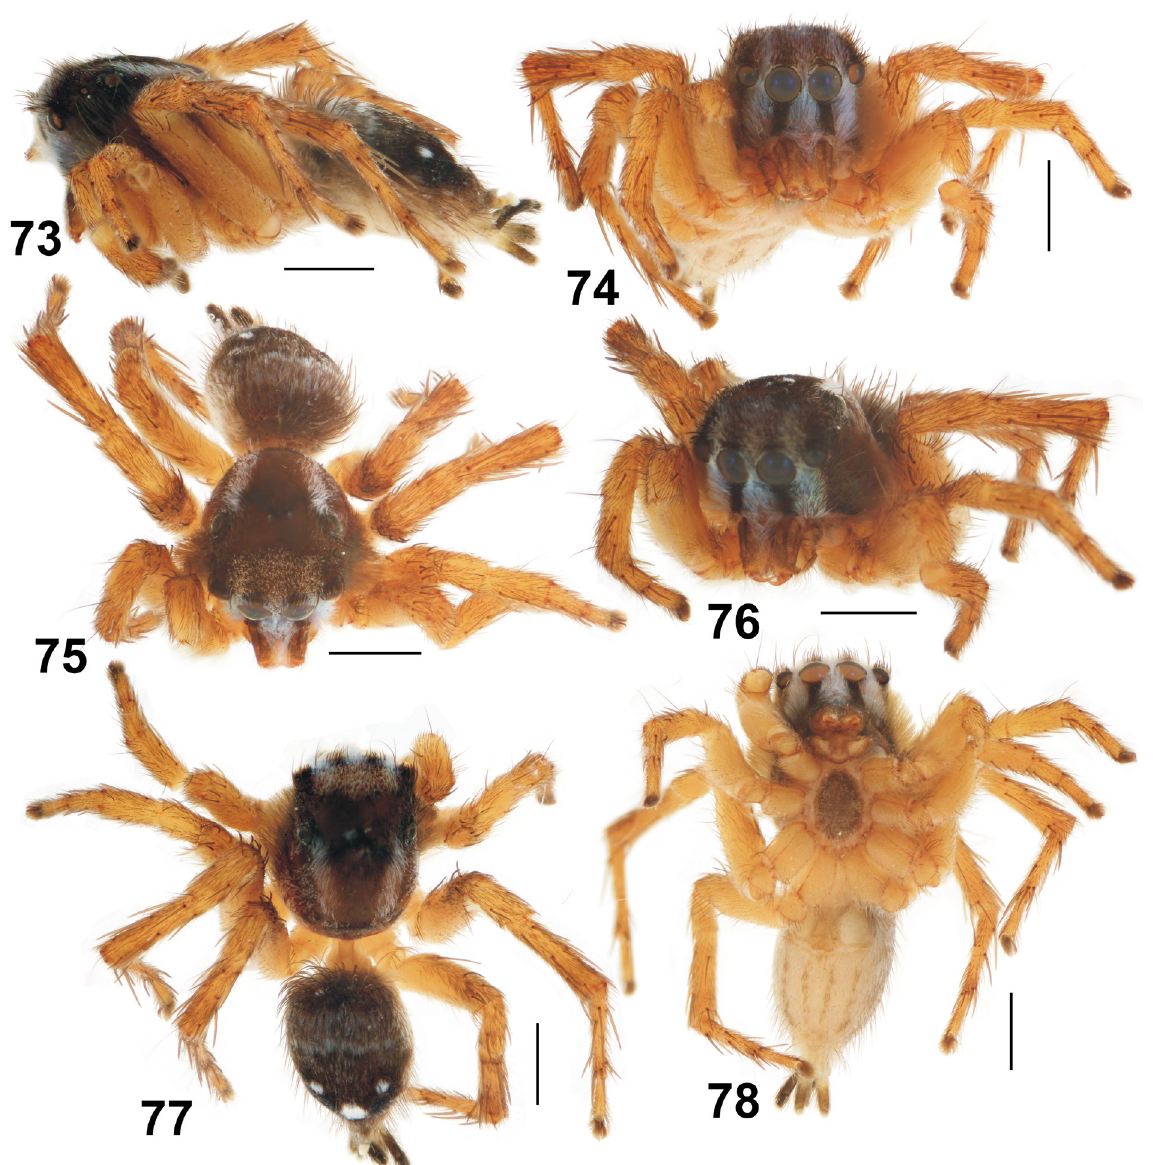
Figs 73–78. Stenaelurillus bandama sp. nov., holotype, ♂, general appearance . Scale bars: 1